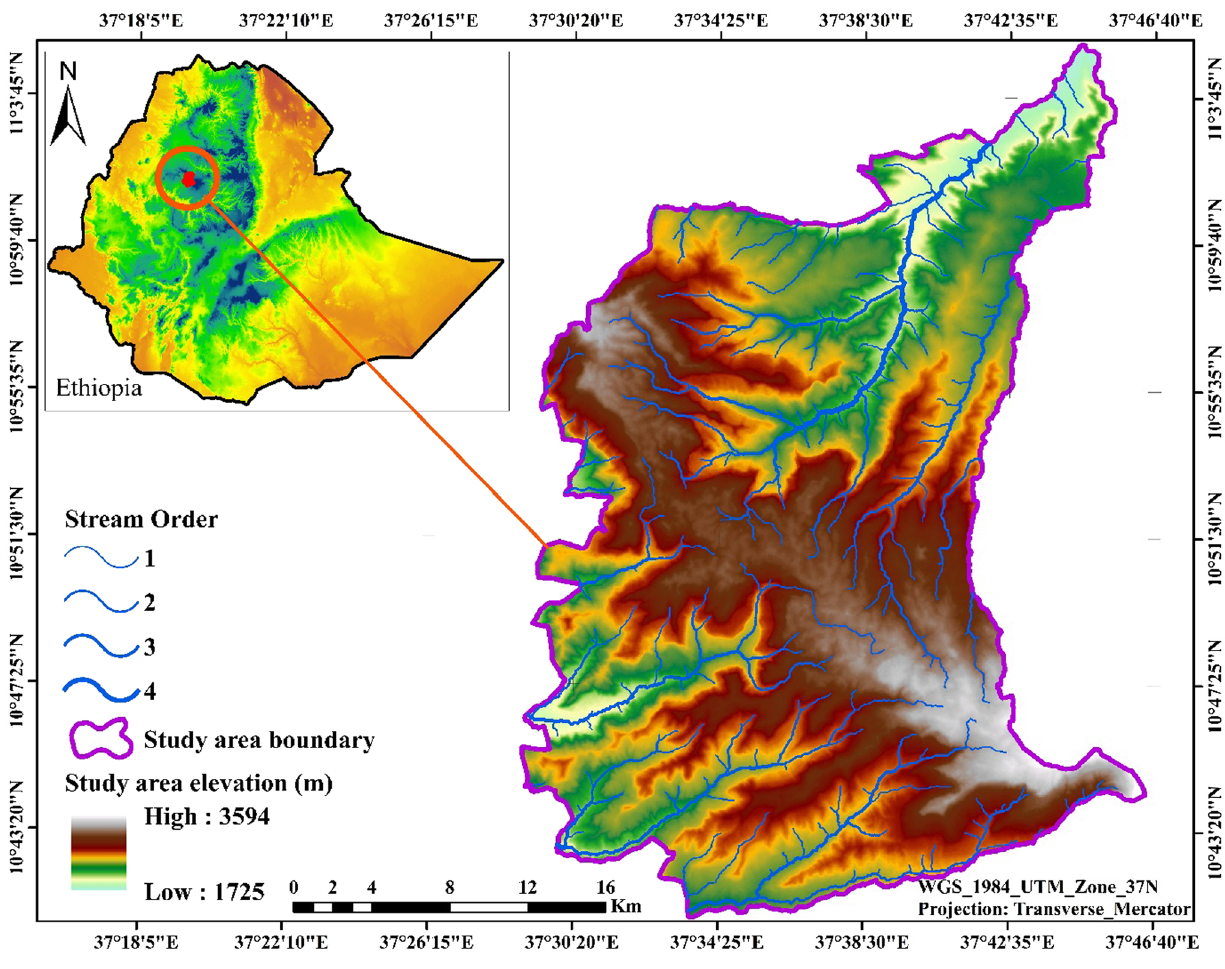
Fig. 1 Location map of the study